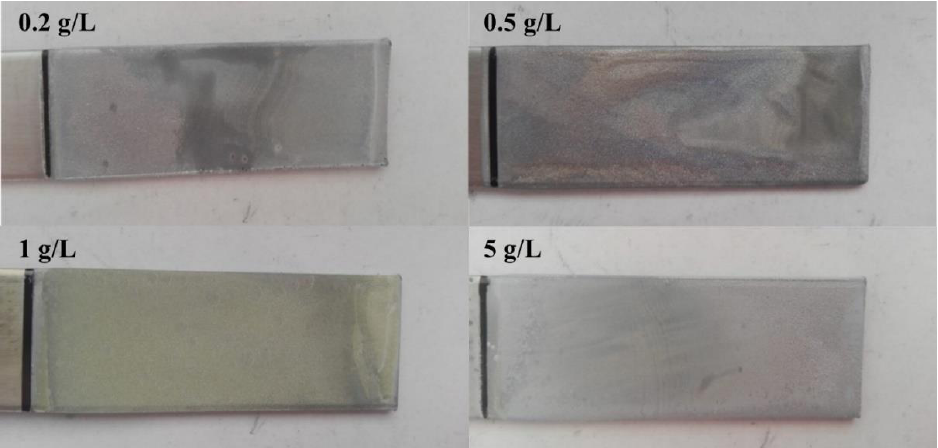
Figure 7 . Photos of electrowon lead at different polyvinylpyrolidone (PVP) concentrations . Figure 7. Photos of electrowon lead at different polyvinylpyrolidone (PVP)